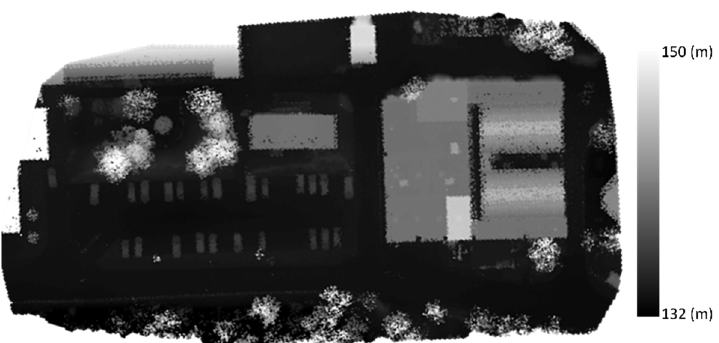
Figure 10. LiDAR point cloud generated using SLAM for the first test site.